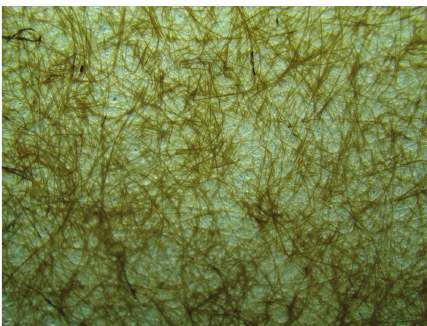
Figure 1: Dimensional randomization of fique mat used in the reinforcement of the